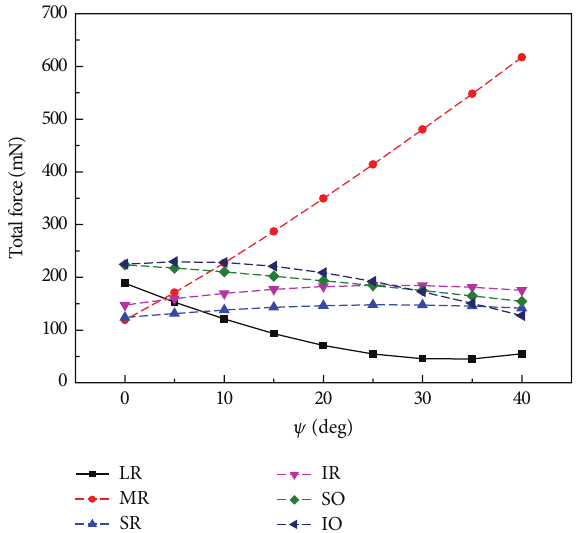
Figure 3: Total forces of EOMs with eye passively rotated temporal- ward in the primary innervations.